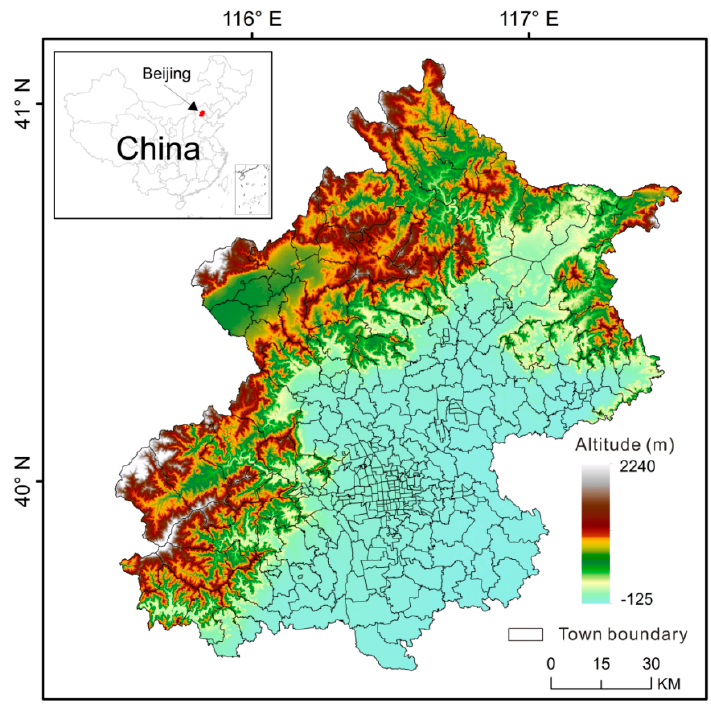
Figure 1. Location and administrative divisions of Beijing.